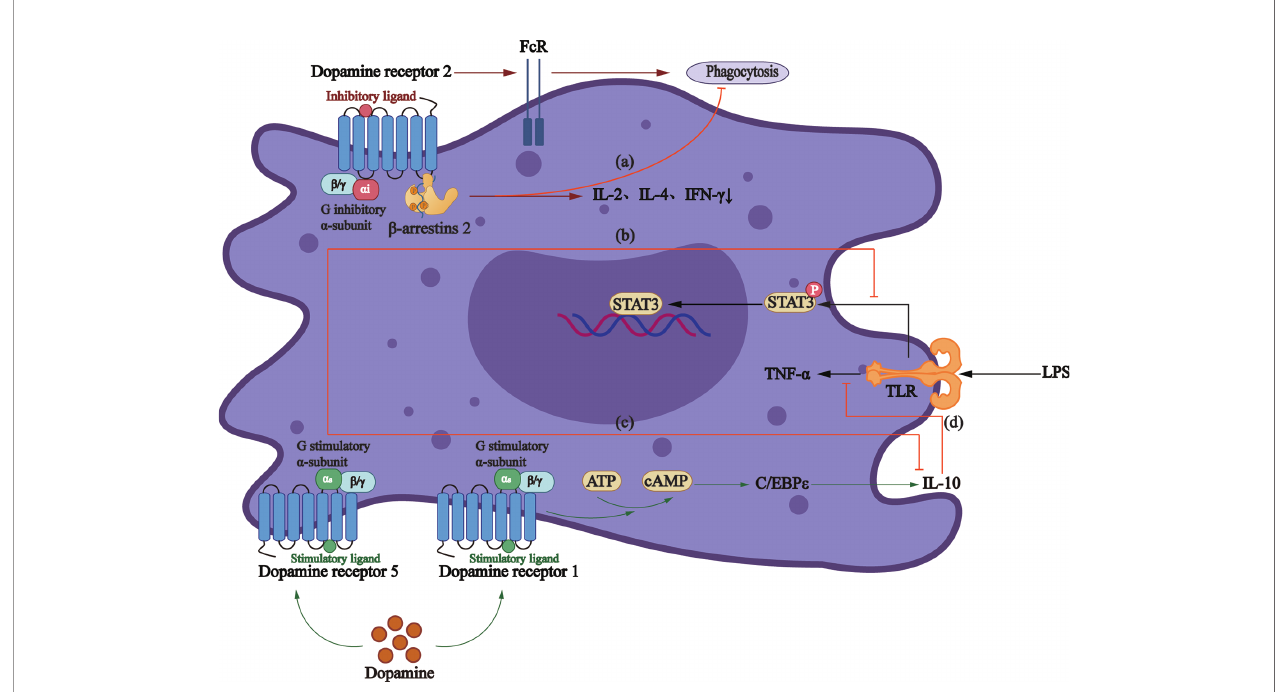
FIGURE 2 | Roles that dopamine receptors play in macrophages. (A) The activation of D2-like DRs can regulate the phagocytic activity of macrophages through b -arrestin2 pathway, and reduce the secretion of IL-2, IL-4, and IFN- g . (B) LPS increases TNF - a production via TLRs and mediates activation of STAT3, which can be inhibited by D5R signaling. (C) Dopamine reduces the production of anti-in fl ammatory factor IL-10 through D5R. (D) D1R/cAMP/C/EBP ϵ signaling increases IL-10 production, thus inhibiting LPS-mediated production of TNF- a